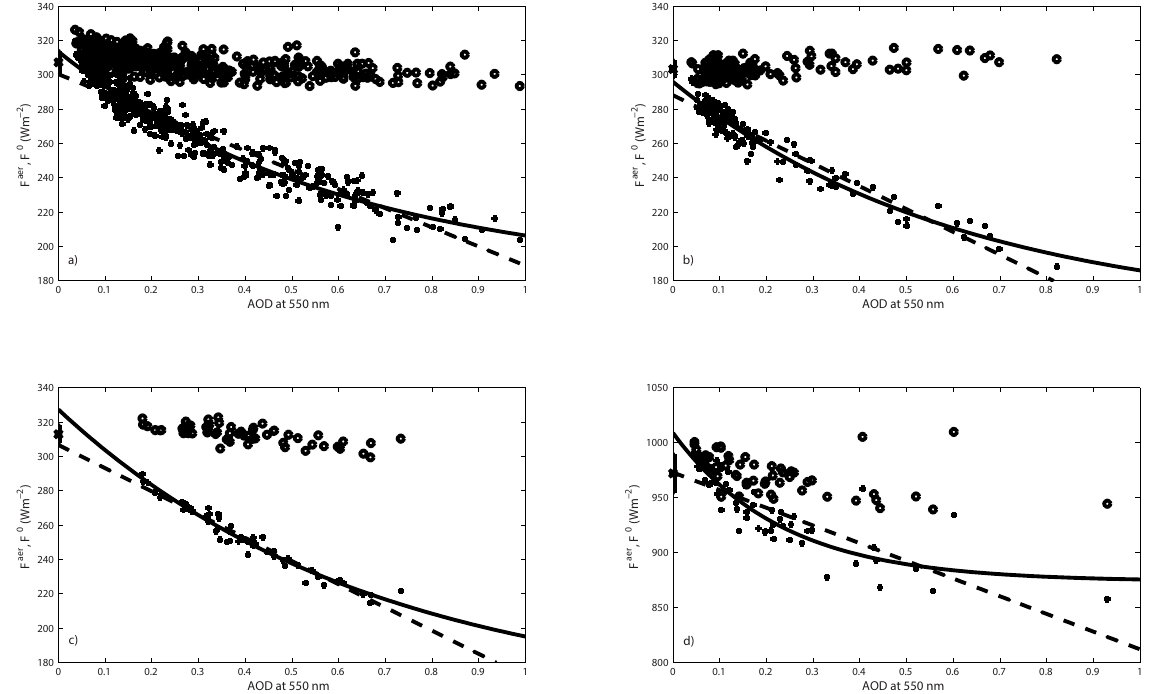
Figure 2. Same as Fig. 1, but for the June–August season in (a) GSFC (SZA = 70 ◦ ), (b) Rio Branco (SZA = 70 ◦ ), (c) Dhadnah (SZA = 70 ◦ ), and (d) GSFC (SZA = 22 ◦